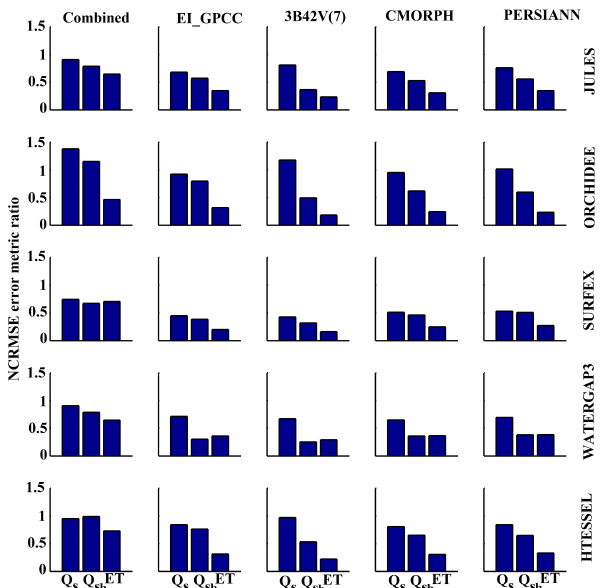
Figure 13. NCRMSE error metric ratios presented for the various products and models at daily scale.